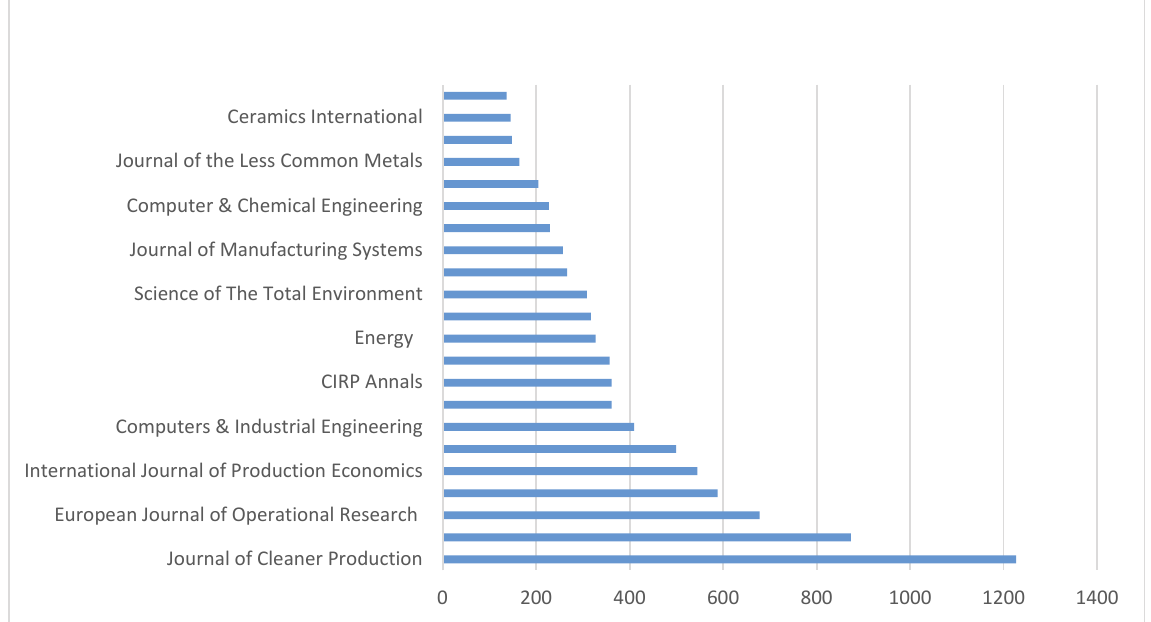
Fig. 2. The number of papers on planning and scheduling for each